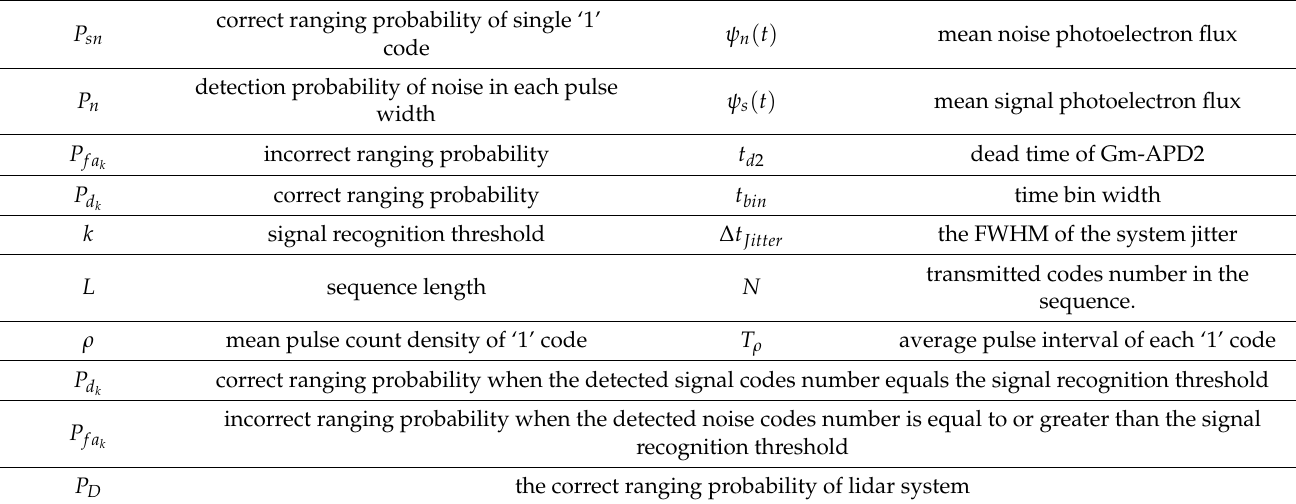
Table A1. List of parameters and